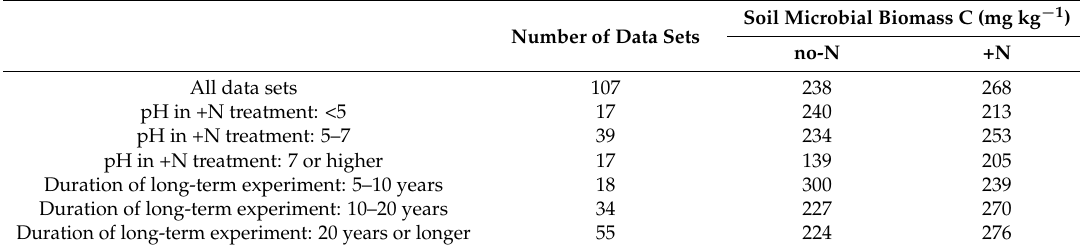
Table 5. Unweighted averages of soil microbial biomass C (mg kg − 1 ) in fertilizer N (+N) and no-N treatments in 64 non-lowland rice long-term experiments from all over the